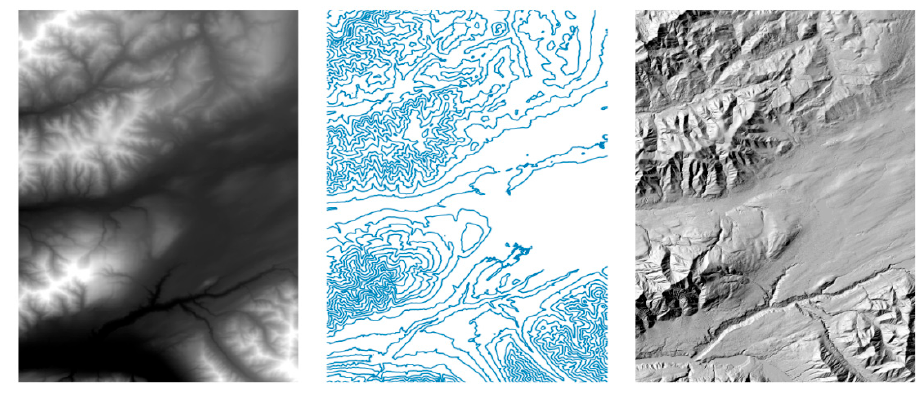
Figure 7. DEM for evaluation.